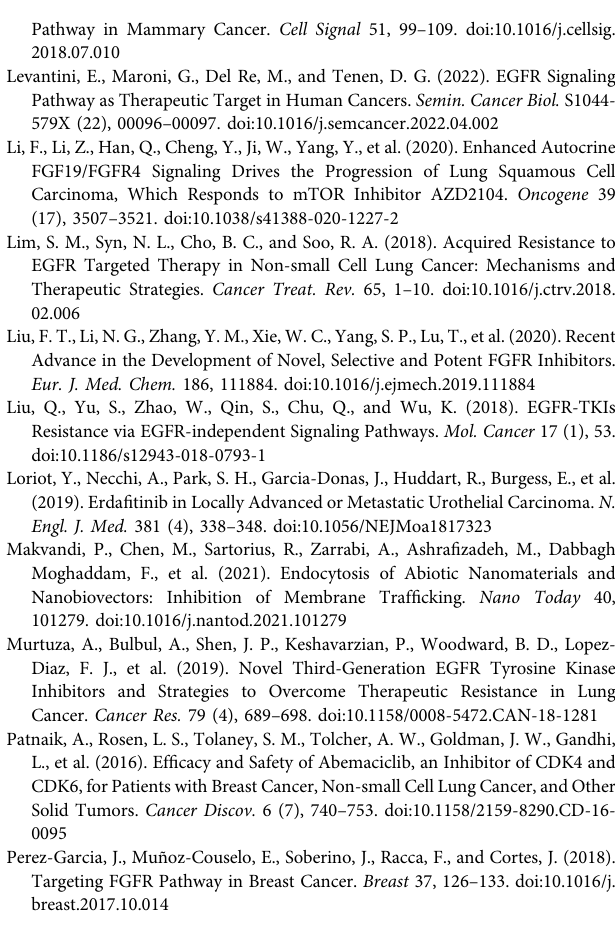
Supplementary Figure S1 | Summary of mechanisms of resistance to different generation EGFR TKIs. (A) The pie chart depicts resistance mechanisms that have been identi fi ed after resistance to fi rst- and second-generation EGFR TKIs. (B) The resistance mechanisms of resistance to third-generation EGFR TKIs. (C) The mechanisms of resistance to all EGFR TKIs after combining the data from (A, B)